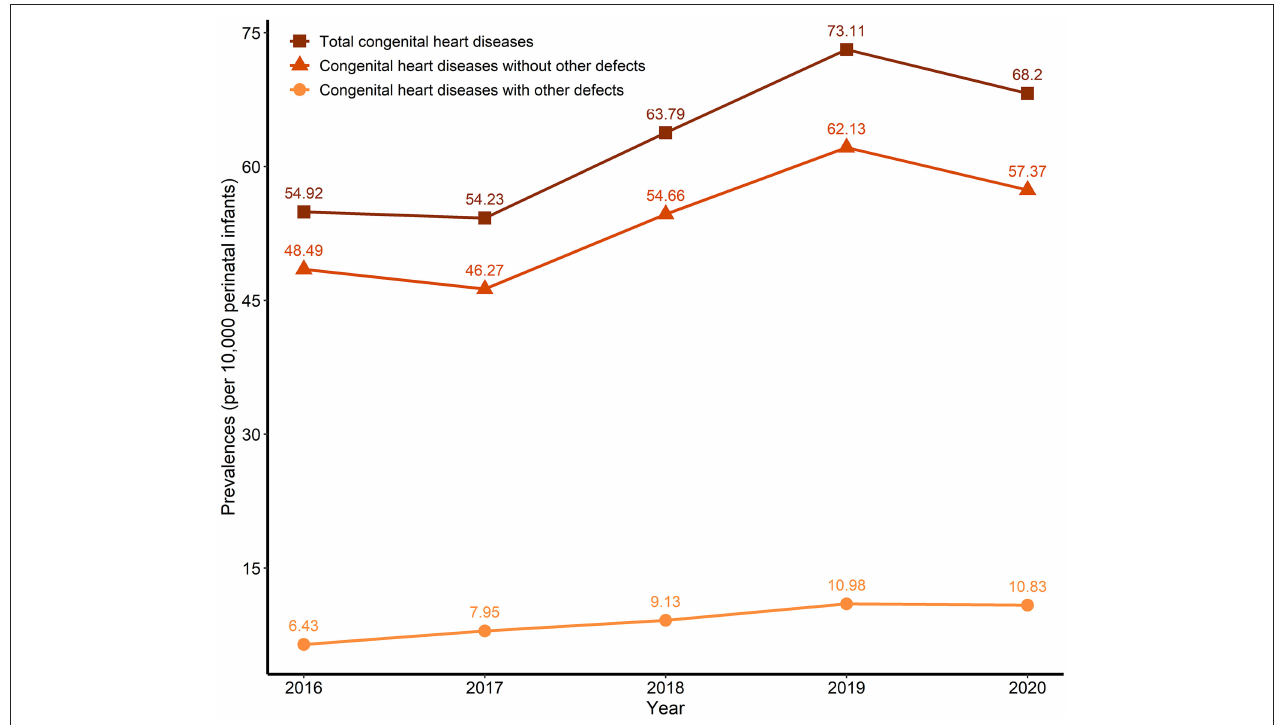
FIGURE 2 | Trends of the prevalence of congenital heart defects (CHDs) (per 10,000 perinatal infants) in Guangdong, China, 2016–2020.